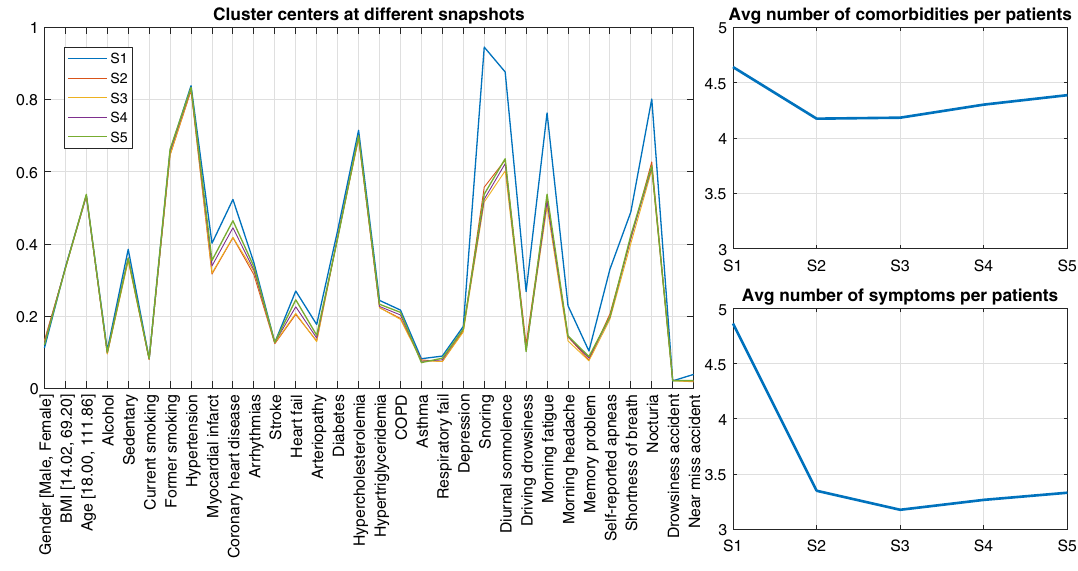
Fig. 20 The change of the group B (oldest, highest comorbidities, and medium OSA severe) from Snapshot 1 to 5